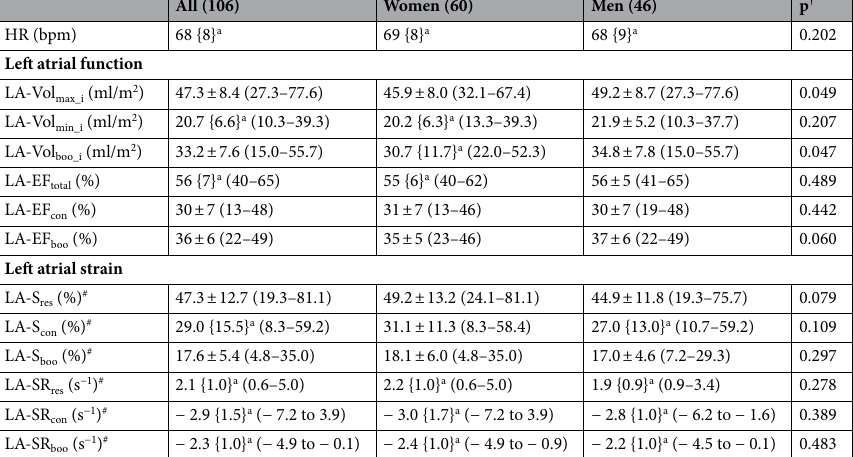
Table 3. Left atrial strain and volumes of the subgroup with heart rates between 60 to 75 beats-per-minute. Normally distributed values were expressed as mean ± standard deviation, otherwise as median ( a ) with interquartile range. Ranges in parentheses. † p-value related to gender. # No statistical difference between the total cohort (see Table 2) and the heart rate subgroup. Normally distributed data were tested by the unpaired t-test, otherwise with the Mann–Whitney-U-test. LA-Vol max_i indexed maximum left atrial volume, LA-Vol min_i indexed minimum left atrial volume, LA-Vol boo_i indexed booster left atrial volume, LA-EF total total left atrial ejection fraction, LA-EF con passive left atrial ejection fraction, LA-EF boo booster left atrial ejection fraction, LA-S res reservoir left atrial strain, LA-S con conduit left atrial strain, LA-S boo booster left atrial strain, LA-SR res reservoir left atrial strain rate, LA-SR con conduit left atrial strain rate, LA-SR boo booster left atrial strain rate.